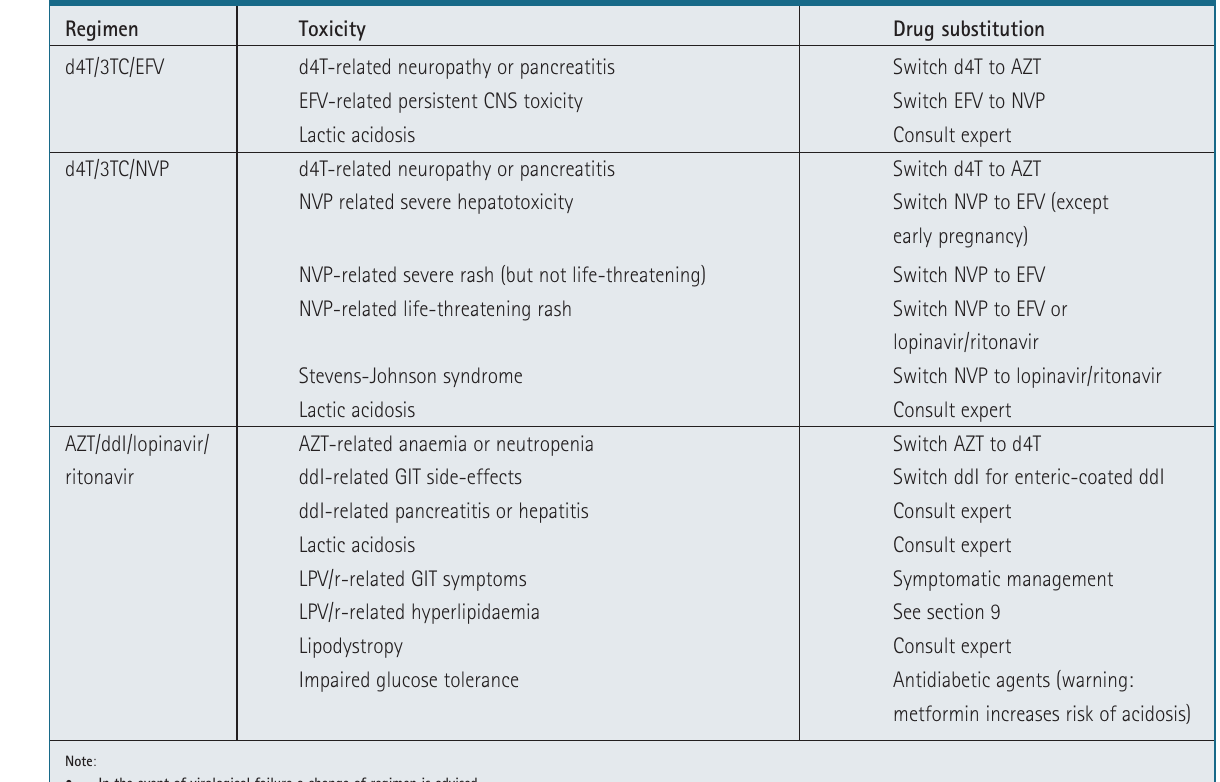
TABLE XIII. RECOMMENDATIONS FOR CHANGING THERAPY IN DRUG